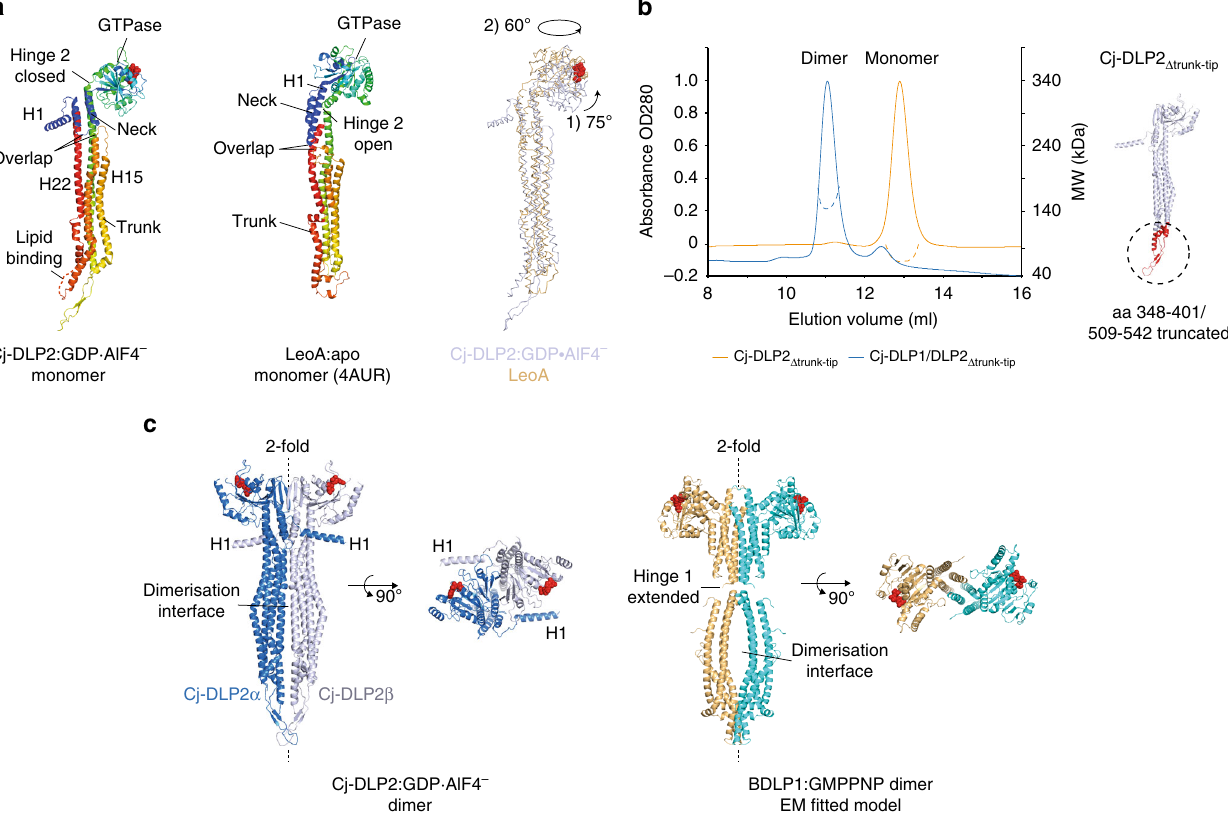
Fig. 3 Structural analysis of Cj-DLP2 bound to GDP·AlF 4 ¯. a Cartoon comparison of Cj-DLP2 monomer with the ETEC DLP LeoA. Blue represents N- terminus through to the red C-terminus. Cj-DLP2 and LeoA have similar neck and trunk architecture with RMSD = 7.0 Å when superimposed (right panel). No distinct hinge 1 region is observed at the neck-trunk interface. The Cj-DLP2 GTPase domain is in a hinge 2 closed position and requires a complex two plane twist to generate the LeoA GTPase domain conformation (open position). The lipid binding domain includes residues 530FVLF534 and is disordered in the model. b SEC-MALS shows that removal of the Cj-DLP2 trunk tip (amino acids 348 – 401 and 509 – 542 coloured in red) abolishes Cj-DLP2 back-to- back cis dimerisation within Cj-DLP1/2 tetramer , and results in Cj-DLP1/2 heterodimer instead. c Focus on the Cj-DLP2 back-to-back cis dimer showing all structural domains including the GTPase, neck and trunk contribute to the 5969 Å 2 dimerisation interface. BDLP1 forms a similar back-to-back dimer when self-assembled as derived from the EM fi tted model